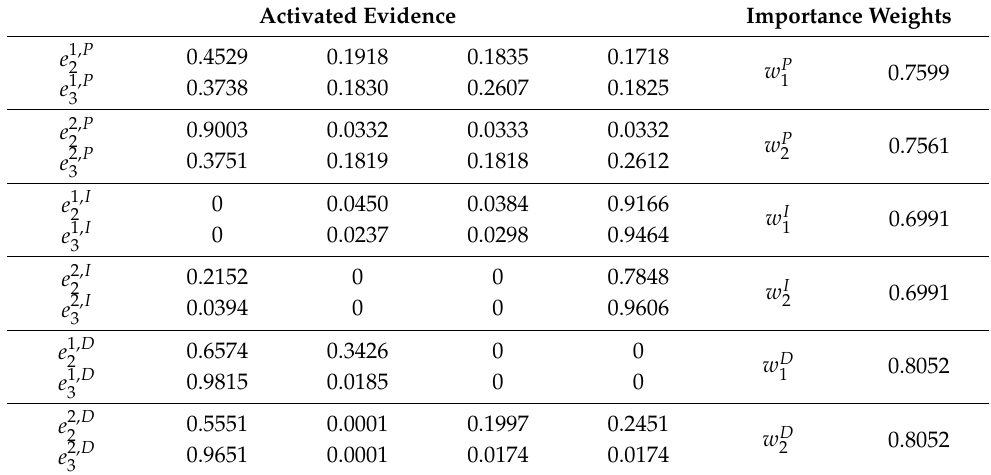
Table 10. Evidence activated at time k = 3 and their corresponding importance weights.